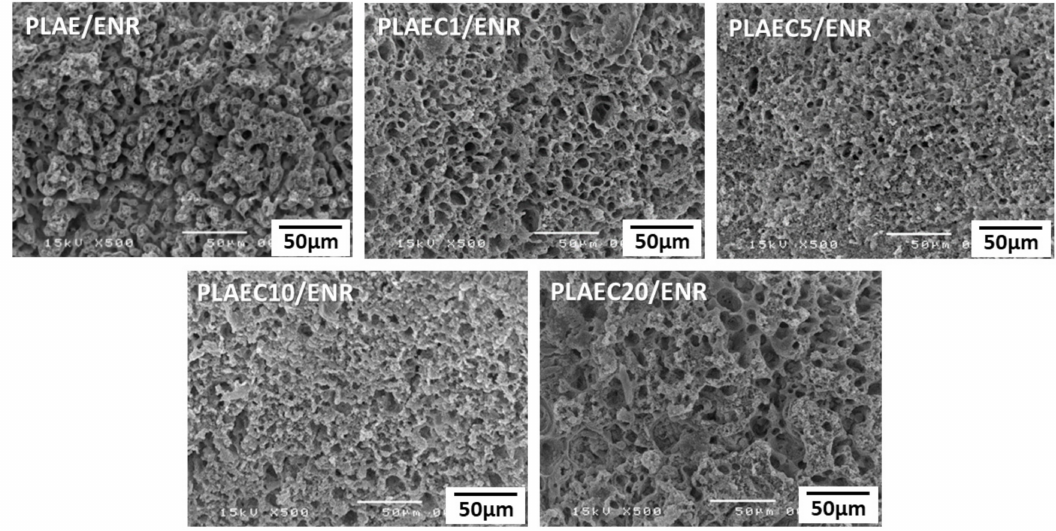
Figure 5. SEM micrographs of PLA and PLAEC/ENR blend with different CTS